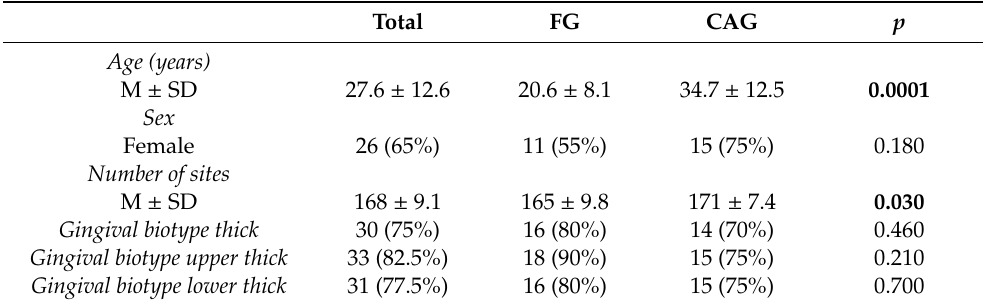
Table 1. Characteristics of the patients included in the study for FG and CAG.